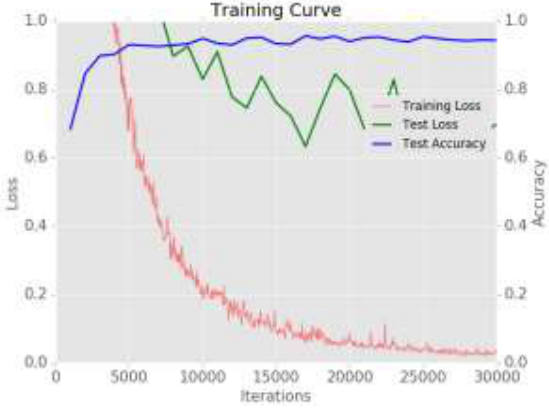
Fig. 8. Training curve with different